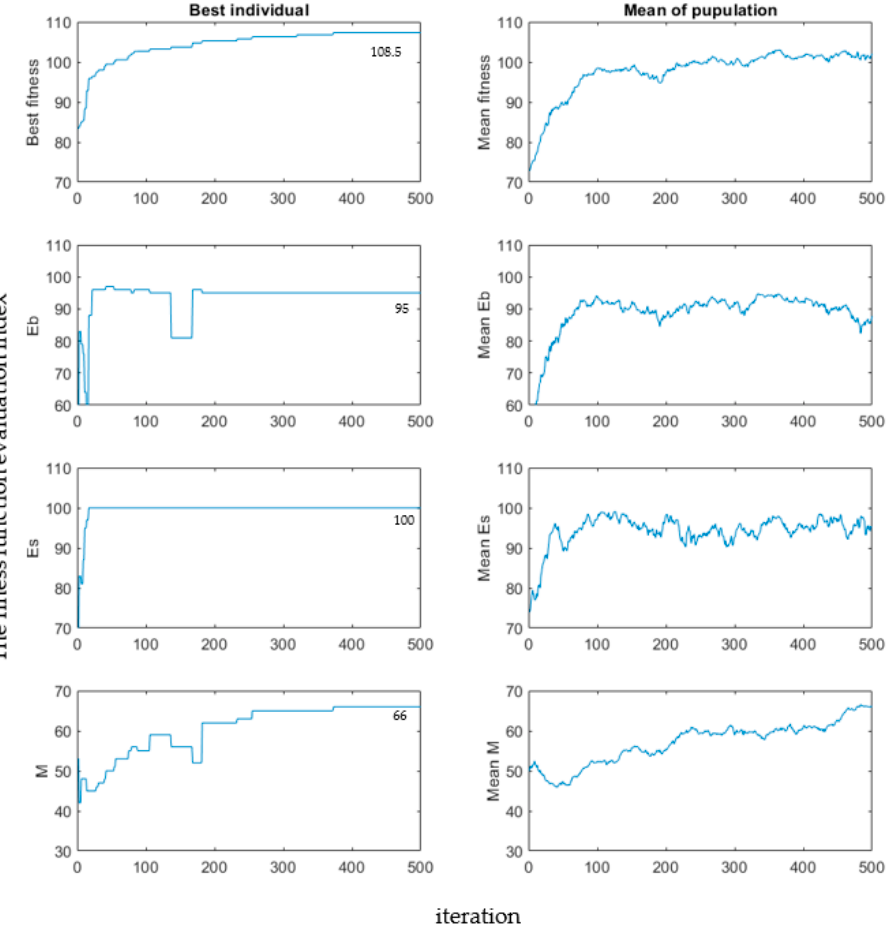
Figure 9. The miniaturized system’s data changes.